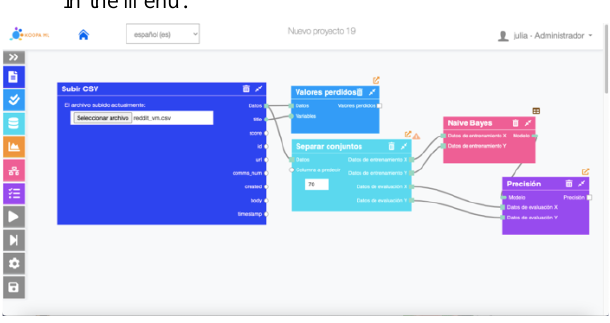
Figure 6. Square nodes in the first